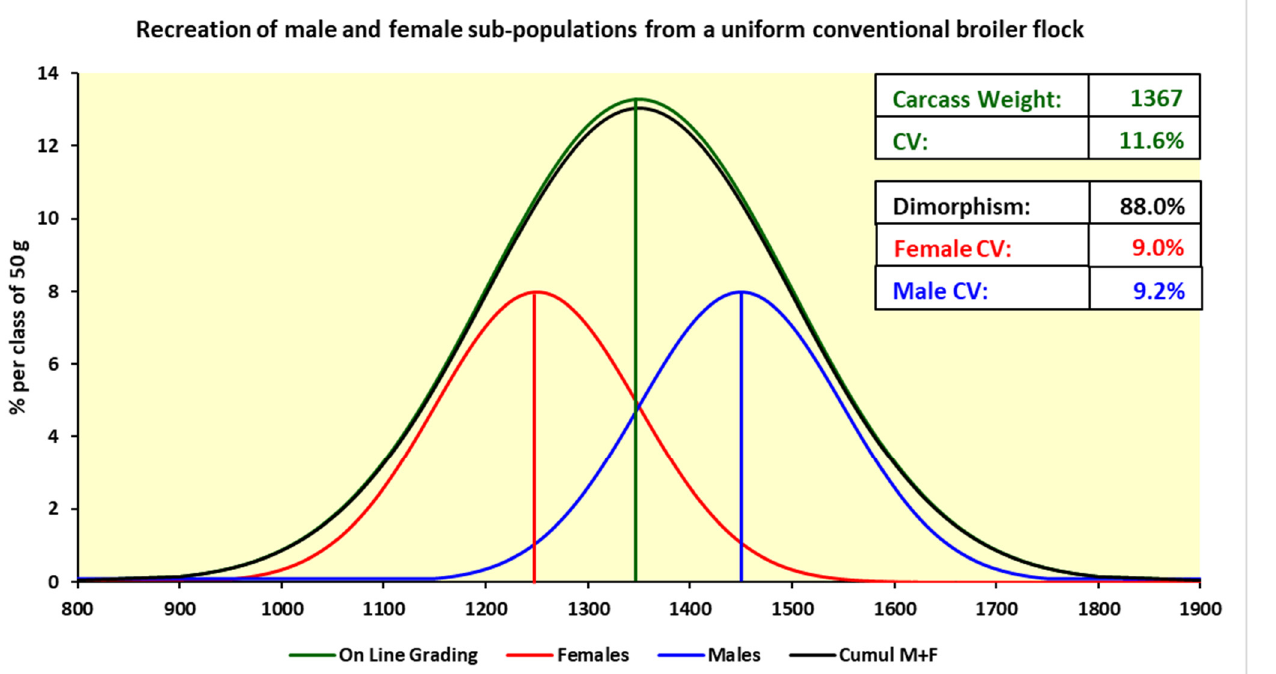
Figure 3. A new generation of automatic breast fillet deboning with the capabilities of measuring the size of each bone-in breast fillet portion to allow adaptive filleting of different size birds. The new generation machines also allow producing a range of products such as half fillets with/without skin, butterfly with/without tenders. Photo courtesy of Marel.